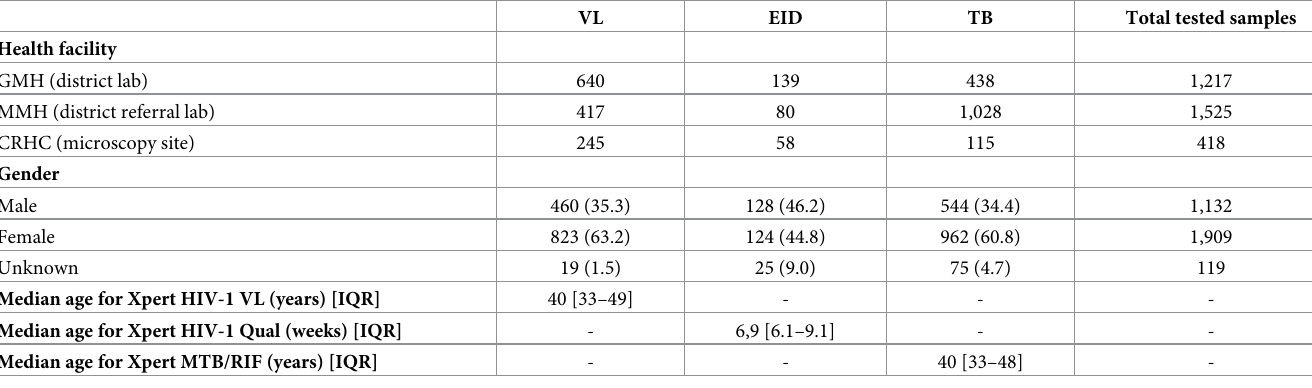
Table 1. Characteristics of patients enrolled into the study across the three